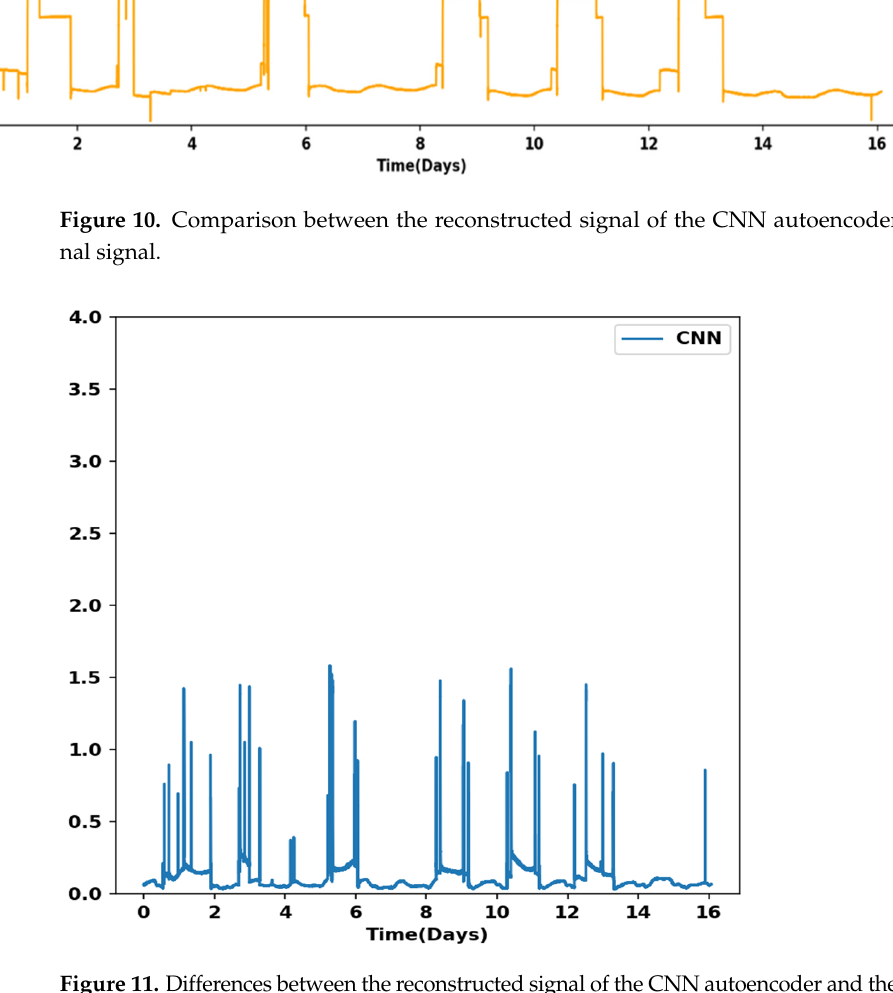
Figure 11. Differences between the reconstructed signal of the CNN autoencoder and the original signal.